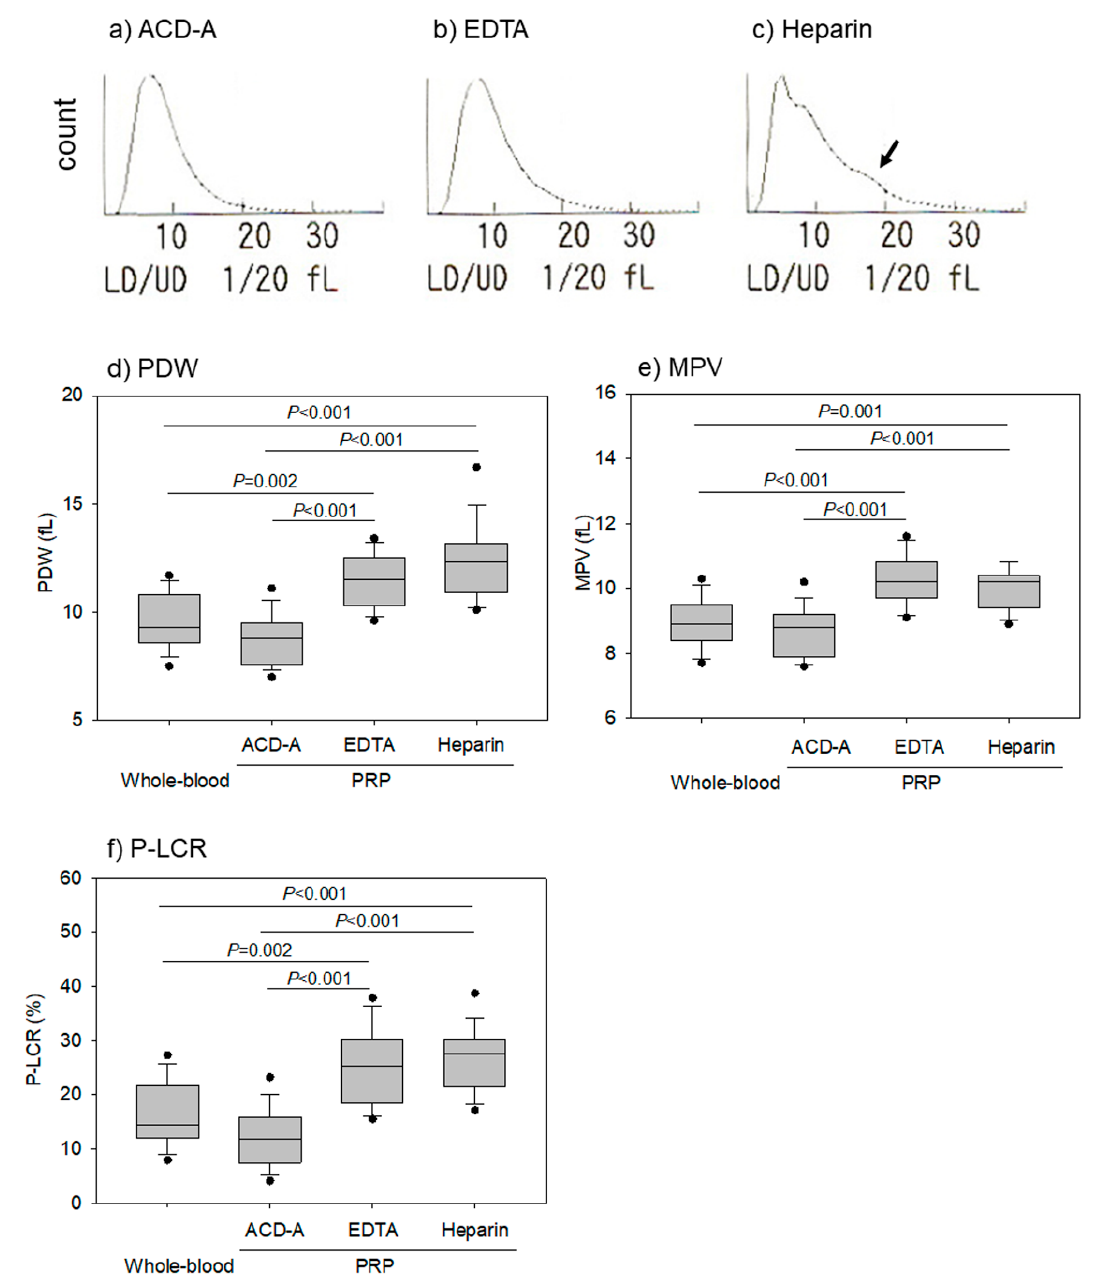
Figure 4. Effects of anticoagulants on platelet size in pure-PRP. Pure-PRP samples were prepared from whole-blood samples stored for 24 h. ( a – c ) Representative platelet histograms. ( d – f ) Parameters of platelet size. n = 15. An arrow in panel c represents platelet detected as “large platelet”.